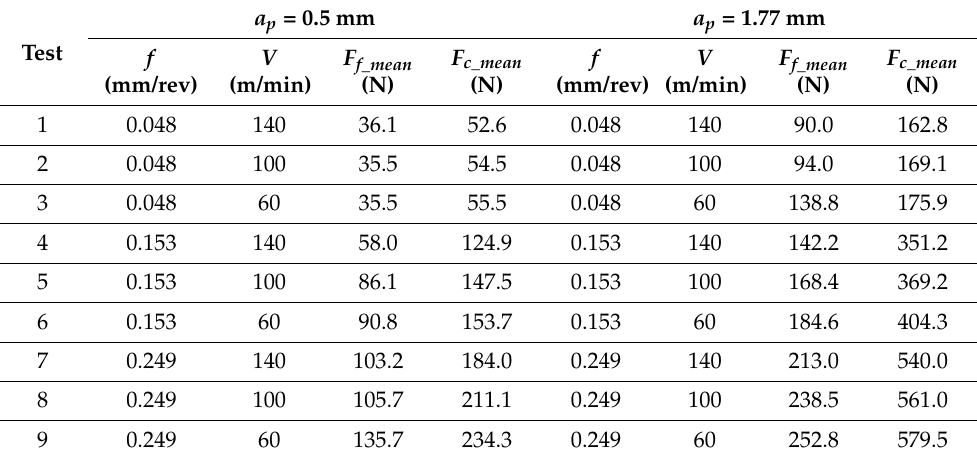
Table 6. Johnson-Cook model constants of GRADE 2 titanium alloy ( (cid:2013) (cid:2868) (cid:4662) = 1; T r = 23 °C).